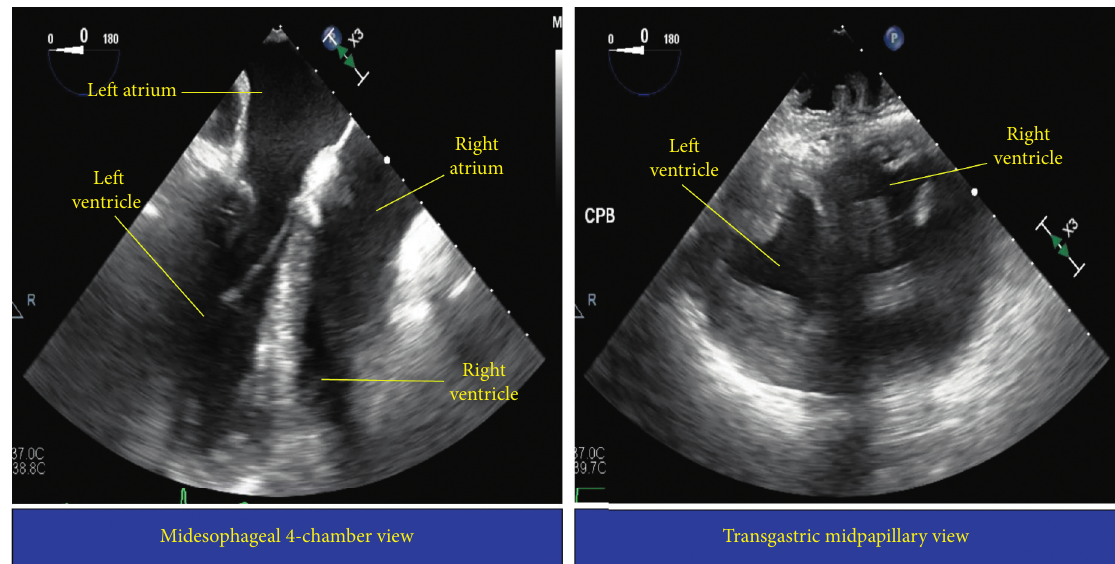
Figure 1: Midesophageal 4-chamber (left) and transgastric midpapillary transesophageal (right) echocardiography